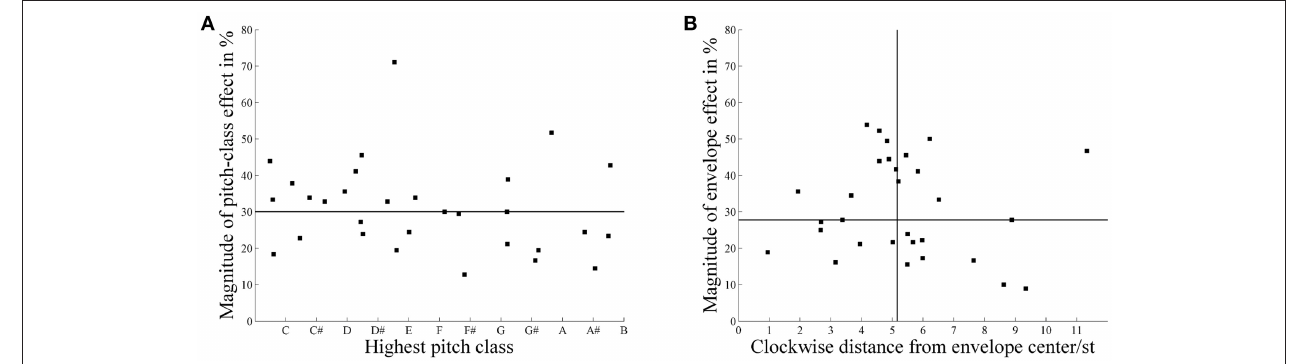
29). (B) Distribution of individual highest pitch classes = 29). The horizontal line represents the median of the individual =